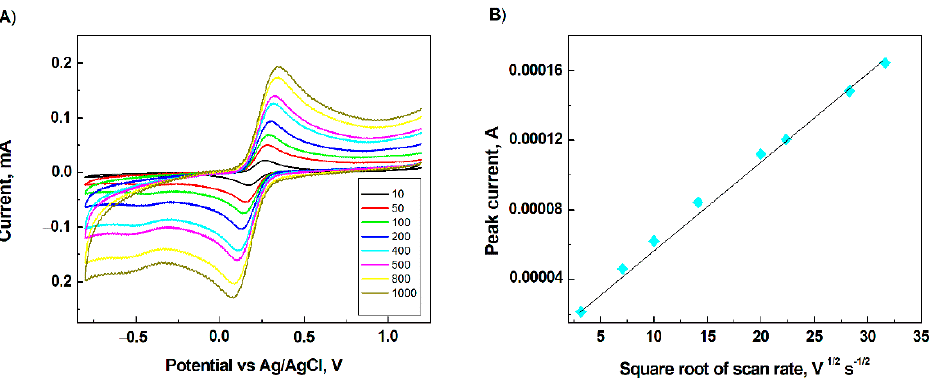
Figure 4. ( A ) Cyclic voltammetric response of the GC/AuNPs/PMS1-modified electrode at scan rates rates (inner to outer) of 10, 50, 100, 200, 400, 500, 800, 1000 mV s − 1 . ( B ) Peak current dependence (inner to outer) of 10, 50, 100, 200, 400, 500, 800, 1000 mV s –1 . ( B ) Peak current dependence on the on the square root of the scan rate. Supporting electrolyte: 1 mmol L − 1 Fe(CN) 6 − 3 /Fe(CN) 6 − 4 in square root of the scan rate. Supporting electrolyte: 1 mmol L –1 Fe(CN) 6–3 /Fe(CN) 6–4 in 0.1 mol L –1 PBS (pH = 7). 0.1 mol L − 1 PBS (pH =